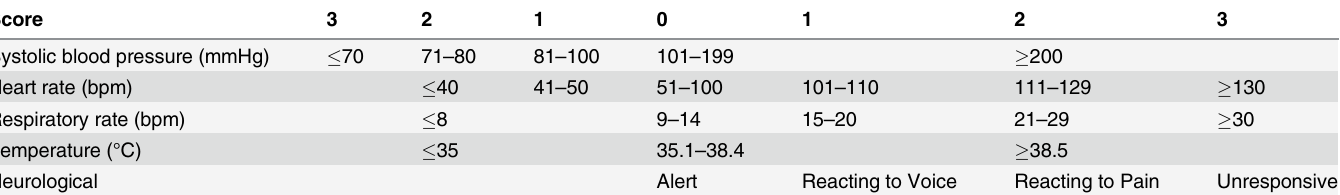
Table 1. Modified Early Warning